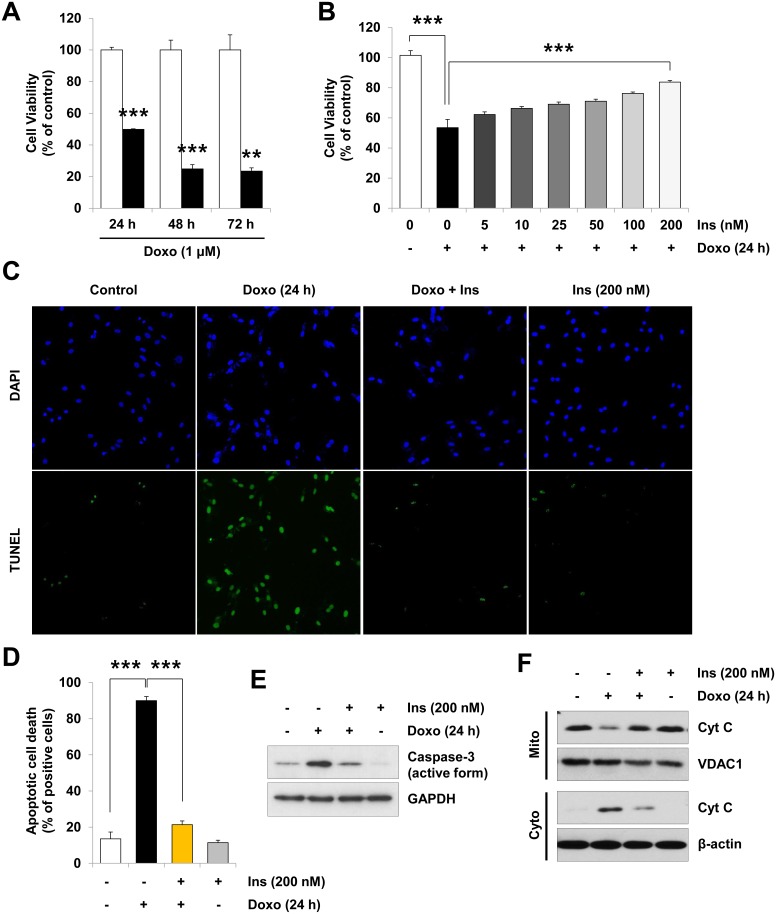
Protective effect of insulin on the doxorubicin-induced cell death in H9c2 cardiac myocytes.(A) H9c2 cardiac myocytes were left untreated or treated with 1 μM doxorubicin (Doxo) for 24 h, 48 h, and 72 h. (B) Serum-deprived H9c2 cardiac myocytes were left untreated or pretreated with the indicated concentration of insulin (Ins) for 1 h prior to treatment with 1 μM doxorubicin (Doxo) for 24 h. Cell viability was assessed by the MTT assay (**p < 0.01; ***p < 0.001, n = 3 performed in triplicates). (C–F) Serum-deprived cells were left untreated or pretreated with insulin (200 nM) for 1 h prior to treatment with doxorubicin (1 μM) for 24 h. (C) Represented images of the TUNEL assay (100×). Treated cells were incubated with TUNEL reaction mixture, followed by staining with DAPI. (D) The TUNEL-stained cells were counted under fluorescence microscopy and presented as a bar graph (***p < 0.001, n = 3 performed in triplicates). (E) Caspase-3 activity was determined by immunoblot analysis of active form of caspase-3. (F) Mitochondrial (Mito) and cytosolic (Cyto) fractions were separated by SDS-PAGE gel and analyzed by immunoblotting with anti-cytochrome C (Cyt C) antibodies. GAPDH or β-actin bands show that equal amounts of sample were loaded and VDAC1 is used as a loading control for mitochondrial fraction. Note that blots represent one of three independent experiments. Values are mean ±S.D.